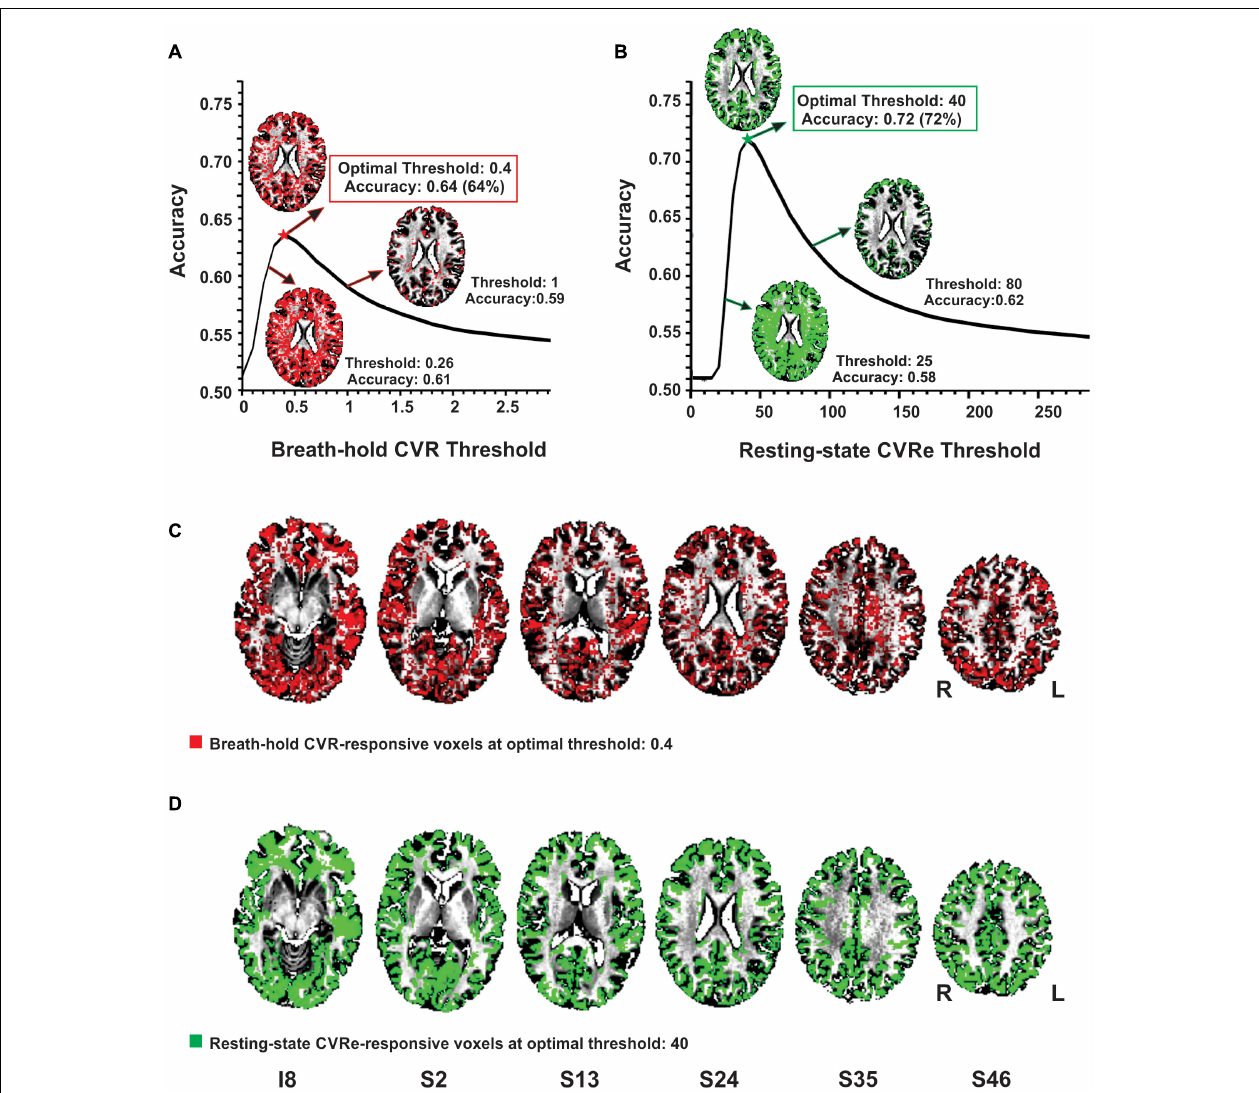
FIGURE 2 | Optimizing thresholds to maximize accuracy of spatial overlap between CVR responses and gray matter. (A) Breath-hold CVR accuracy vs. threshold with example CVR brain patterns (red) for thresholds (beta coefficients) of 0.26, 0.4, and 1. (B) Resting-state CVRe accuracy vs. threshold with example CVRe brain patterns (green) for thresholds (ALFFs) of 25, 40, and 80. By decreasing the threshold from 1 to 0.26 in (A) , and from 80 to 25 in (B) , more complete coverage of the gray matter is obtained but at the cost of inappropriate labeling of white matter. (C , D) Axial brain maps for thresholds marked by stars in (A,B) that optimized overlap accuracy of gray matter with breath-hold CVR ( C: red) and resting-state CVRe ( D: green). Labels below images indicate relative slice position in mm (I, inferior; S, superior). Accuracy is defined in Equation 3. Slice right/left (R/L) orientation is radiologic